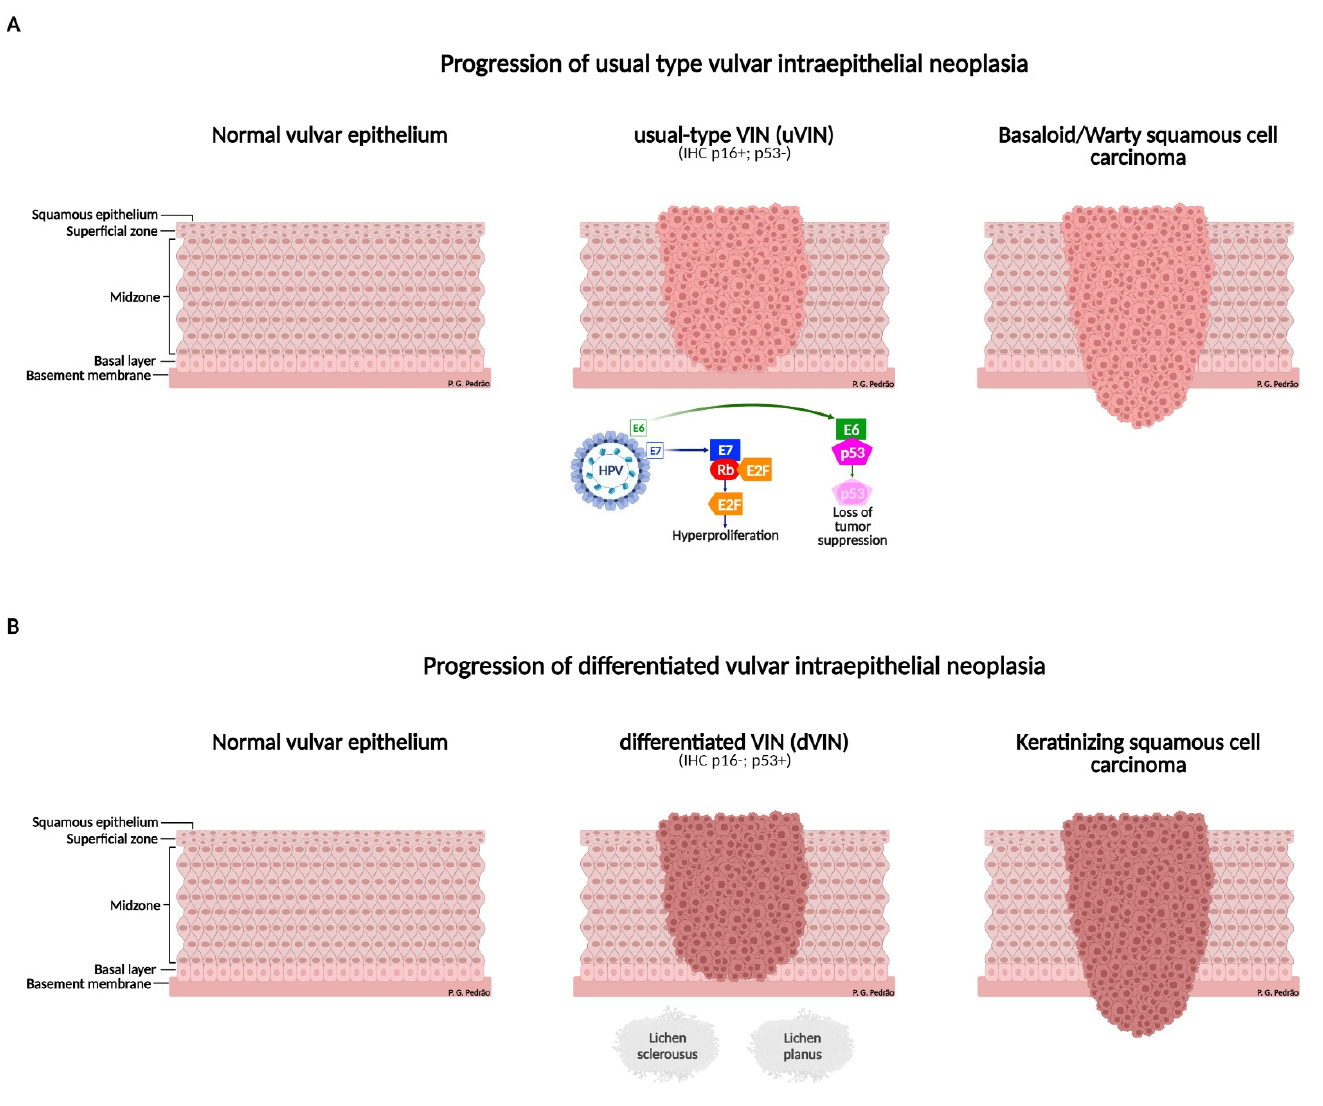
Figure 3. Development of squamous cell carcinoma of the vulva. ( A ) Progression of usual type vulvar intraepithelial neoplasia (uVIN). Usual VIN: associated with HPV infection, the E6 oncoprotein of the virus degrades the tumor suppressor protein, p53, and the E7 oncoprotein inactivates the retinoblastoma protein, Rb, which is also a tumor suppressor protein, releasing transmission factors, E2F, causing cellular hyperproliferation. In immunohistochemistry, the p16 biomarker is positive and p53 is negative. ( B ) Progression of differentiated vulvar intraepithelial neoplasia (dVIN). Differentiated VIN: it is not related to HPV infection, but arises through chronic dermatoses, mainly lichen sclerosus and lichen planus, which can progress to squamous cell carcinoma of the vulva. In immunohistochemistry, the p16 biomarker is negative and p53 is positive. uVIN: usual type vulvar intraepithelial neoplasia; dVIN: differentiated vulvar intraepithelial neoplasia; HPV: human papillomavirus; IHC: immunohistochemistry; VIN: vulvar intraepithelial